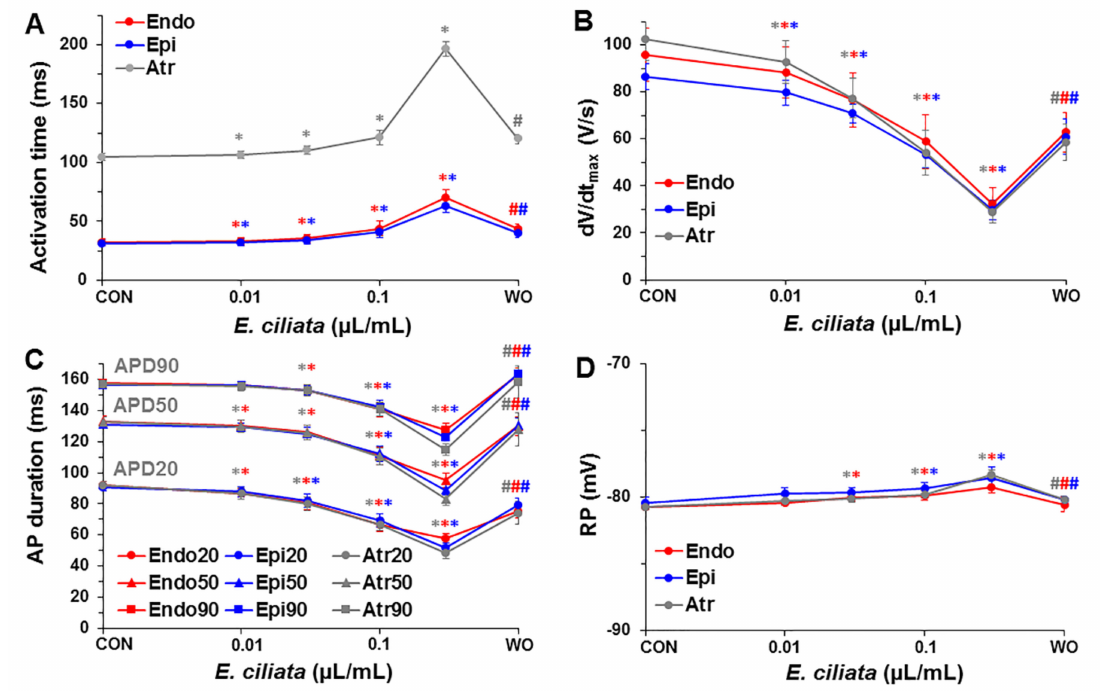
Figure3. DependenceoftheAPparameterson E.ciliata concentrations. Steady-statelevelmeasurements during atrial / endo- / epi-cardial stimulation (300 ms period) of ( A ) activation time, ( B ) the maximal velocity of AP upstroke depolarization (dV / dt max ), ( C ) AP duration (APD) at 20%, 50% and 90% repolarization, and ( D ) resting potential (RP), measured under control conditions (CON) and at the end of 10 min perfusion with each of 0.01, 0.03, 0.1 µ L / mL concentrations of the E. ciliata (except for 0.3 µ L / mL, which was ~5 min), followed by a washout period (WO) (* p < 0.05 for E. ciliata vs. control; # p < 0.05 for washout vs. E. ciliata of 0.3 µ L / mL concentration; n = 7 for